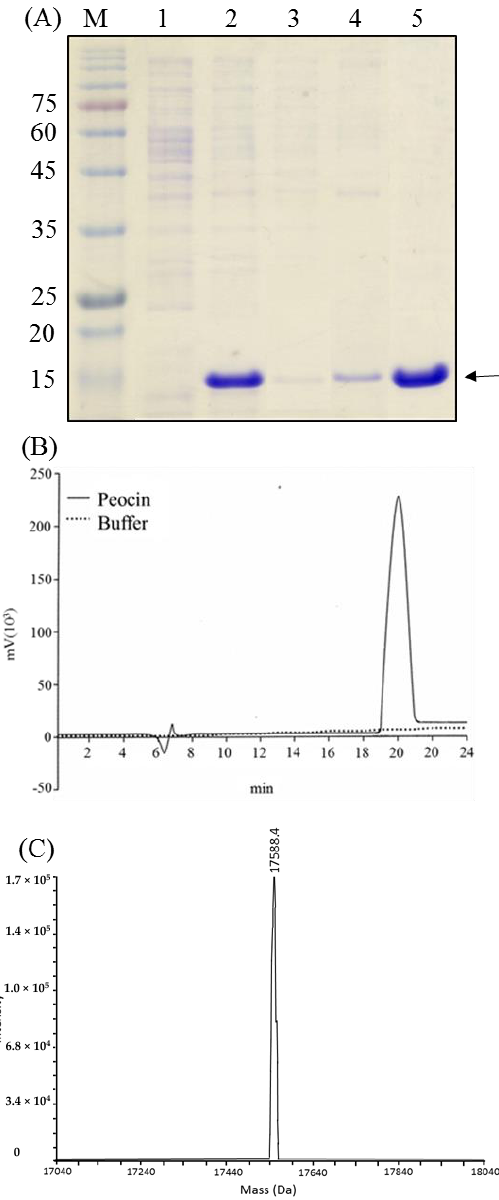
Figure 5. ( A ) Samples from each purification step of Ni-NTA a ffi nity chromatography analyzed by 15% SDS-PAGE. Lane M: molecular mass standard; lanes 1 and 2, supernatant from E. coli BL21(DE3) / pET-peocin without and with IPTG induction, respectively; lane 3, flow through from the nickel a ffi nity column; lane 4, flow through after washing with PBS containing 30 mM imidazole; lane 5, sample after eluting with PBS containing 250 mM imidazole and dialysis; ( B ) Reverse phase HPLC analysis of purified peocin; ( C ) Measurement of the molecular weight of purified peocin by MS analysis.